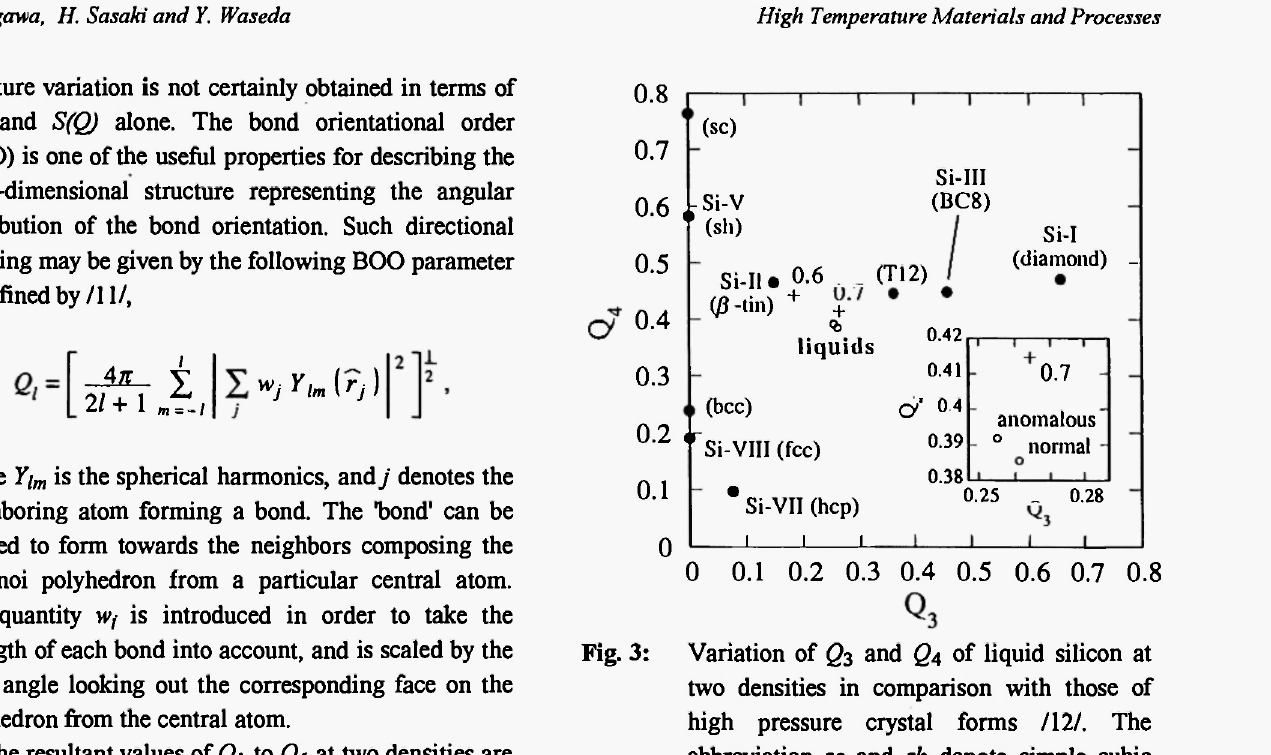
Fig. 3: Variation of Q3 and Q4 of liquid silicon at two densities in comparison with those of high pressure crystal forms /12/. The abbreviation sc and sh denote simple cubic and simple hexagonal, respectively. Crosses and the associated numbers denote the ß-tin structures and their c/a ratios.